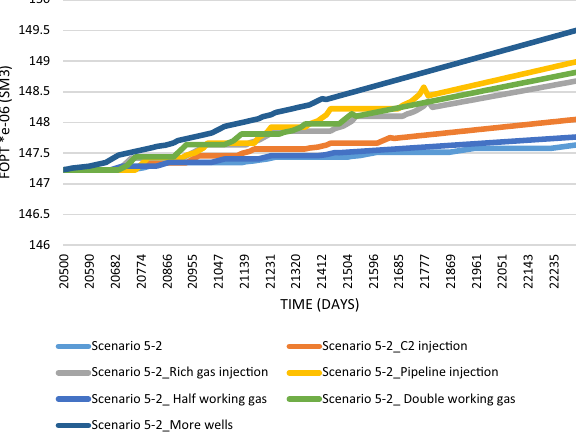
Fig. 11 An increased cumulative condensate production rate under different